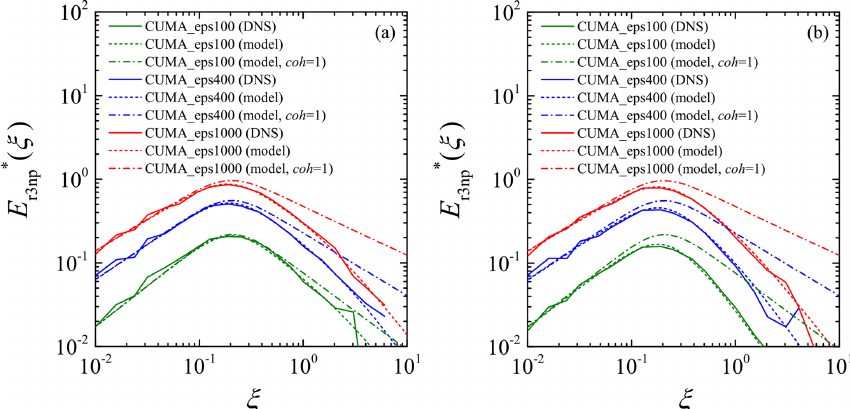
(ξ) obtained from DNS data and estimated by the proposed cross spectrum r3np